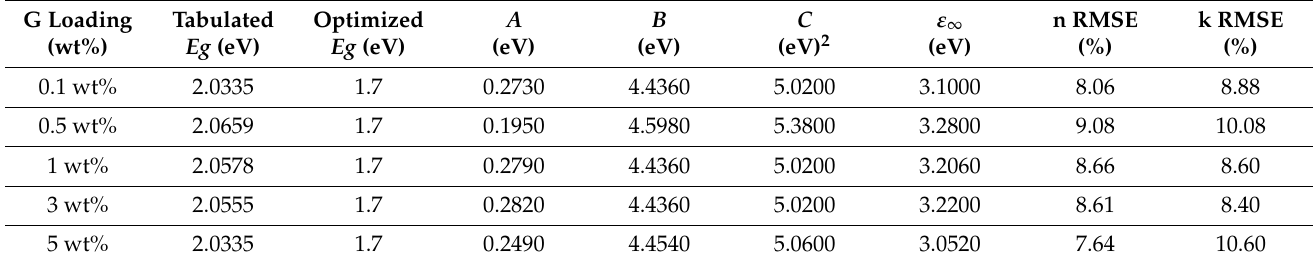
Table 3. Optimal values of the fitting parameters to the Forouhi Bloomer model for six different